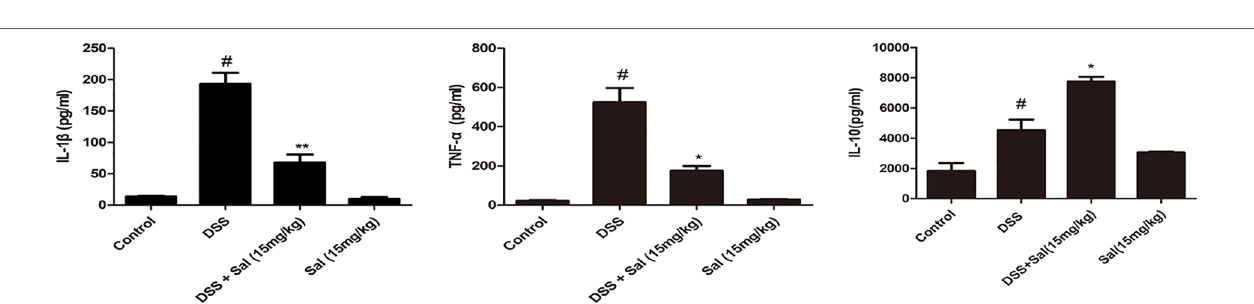
FIgURe 2 | Salidroside adjusted the inflammatory conditions in dextran sulfate sodium (DSS)-treated mice. IL-1β, TNF-α, and IL-10 protein level in the colonic tissue were detected by enzyme-linked immunosorbent assay. Data were presented as the means ± SD. (*) p < 0.05 and (**) p < 0.01 vs . the DSS-treated group; ( # ) p < 0.05 vs . the control